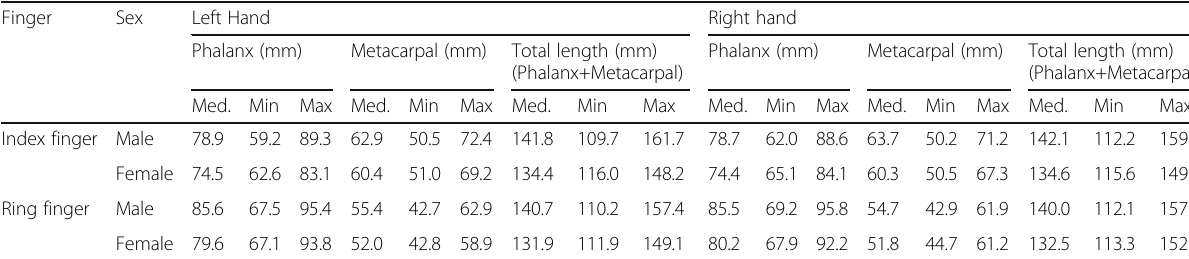
Table 2 Bone lengths Finger